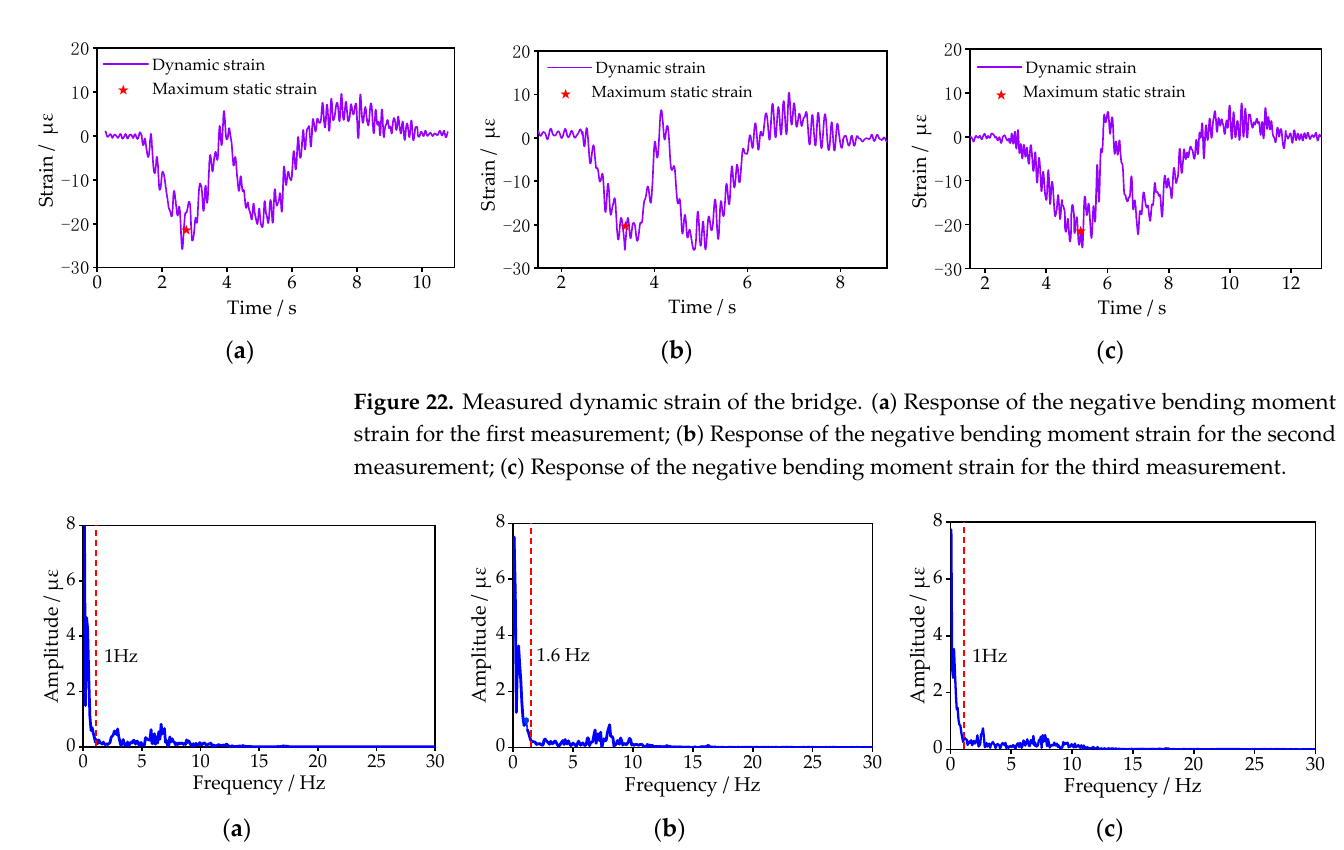
Figure 23. Power spectrum of the measured strain response. ( a ) Power spectrum for the first measurement; ( b ) Power spectrum for the second measurement; ( c ) Power spectrum for the third measurement.